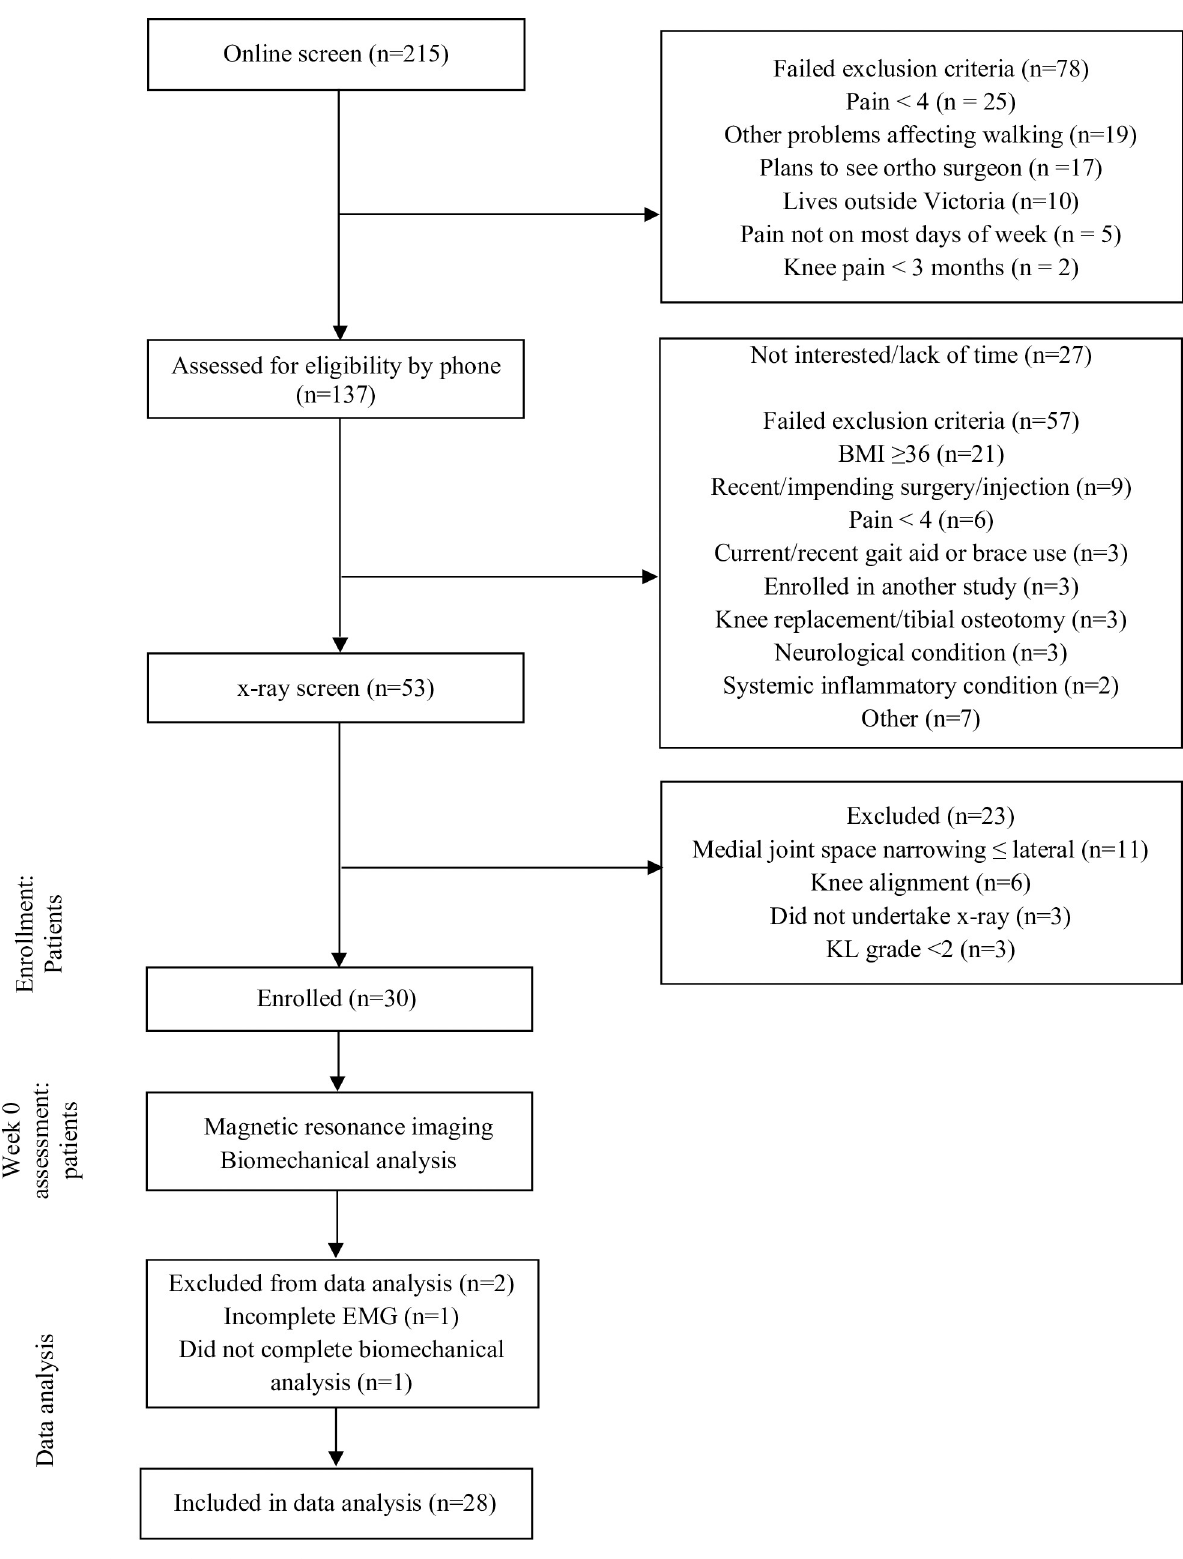
Fig 1. Flow-diagram of study procedures.